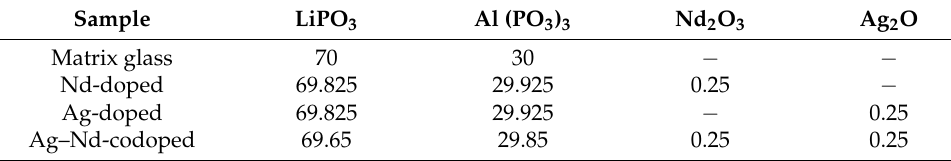
Table 1. Four Differently Doped Phosphate Glass Compositions